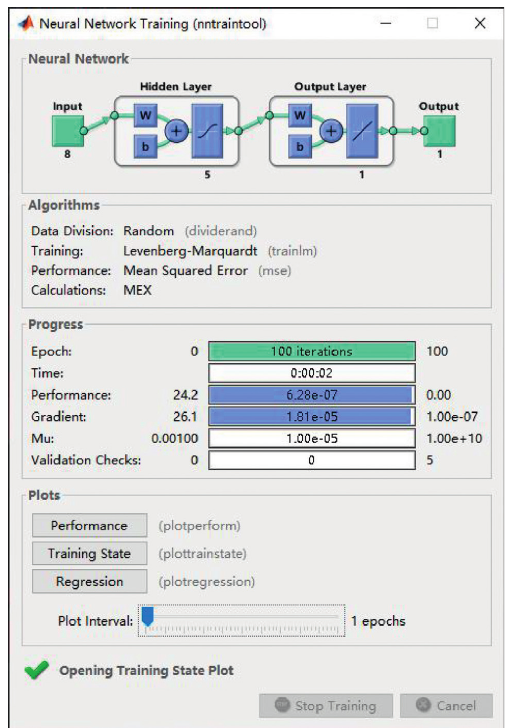
Figure 4: The overall modeling network state